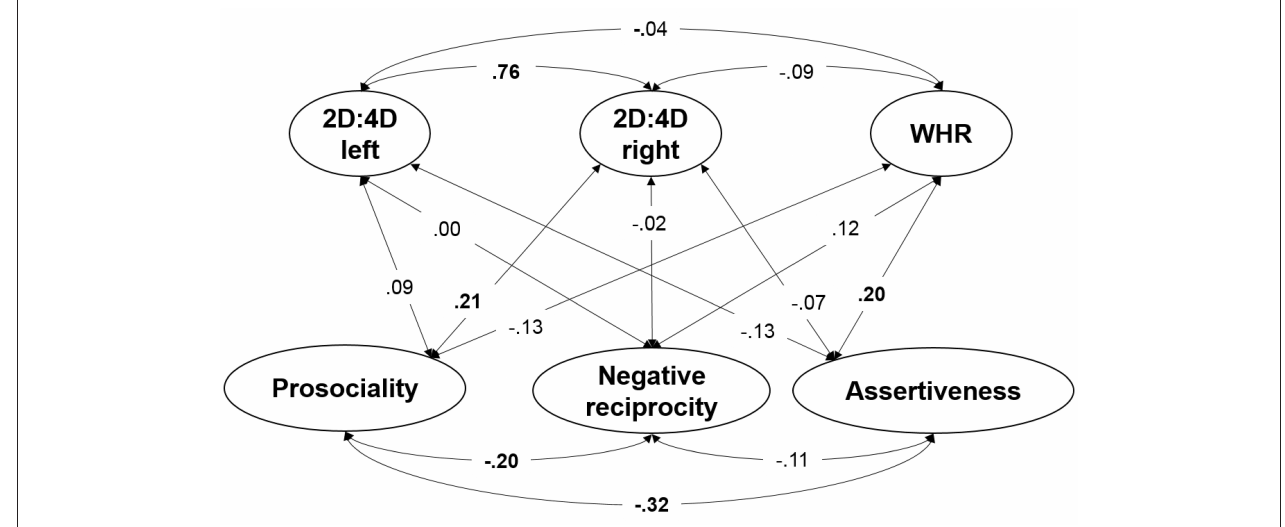
FIGURE 4 | Schematic representation of the structural model testing the relationship between prenatal and pubertal organizational effects of hormones and prosociality, negative reciprocity and assertiveness. Significant relationships between latent factors at p < 0.05 are depicted in bold. See the caption of Figure 2 explaining the general conventions of the graphical language visualizing latent variable models. Note that for simplicity Figure 4 only depicts the latent variables. The measurement models of each latent variable included in this structural model was the same as shown in Figure 2 for the latent variables representing prenatal and pubertal organizational effects and Figure 3 for the latent variables quantifying prosociality, negative reciprocity and assertiveness.